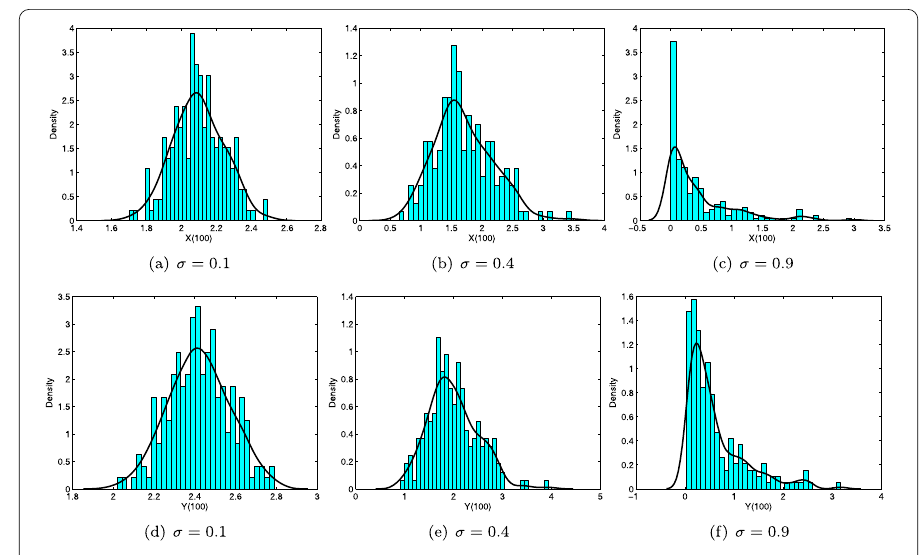
Figure 4 Histogram of the probability density function of x (100) and y (100) for model (4), the smooth curves are the probability density functions of x ( t ) and y ( t ), respectively